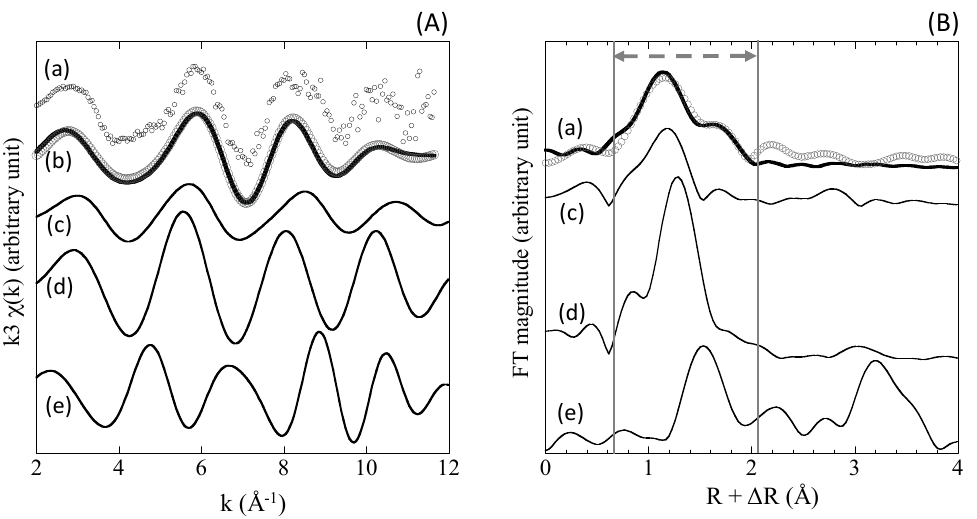
Figure 3. Mo K-edge EXAFS spectra in ( A ) k and ( B ) R spaces for S10.2 and related reference materials. Spectra (a) in k and R spaces are presented as small circles for S10.2. Fitting of the spectrum (a) in R space by assuming Mo–O shells in heptamolybdate ion in water (c), molybdate ion in water (d), and MoO 2 (e) is shown as a bold solid curve. Inverse Fourier transform spectrum for S10.2 ( R range: 0.65–2.05 Å) is shown as small circles of spectrum (b) in ( A ) with a fitted curve (bold) by assuming three Mo–O shells in heptamolybdate ion in water (c), molybdate ion in water (d), and MoO 2 (e).